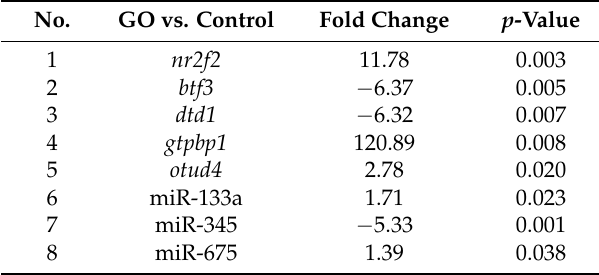
Table 3. Real-Time qPCR validation of differentially expressed genes and